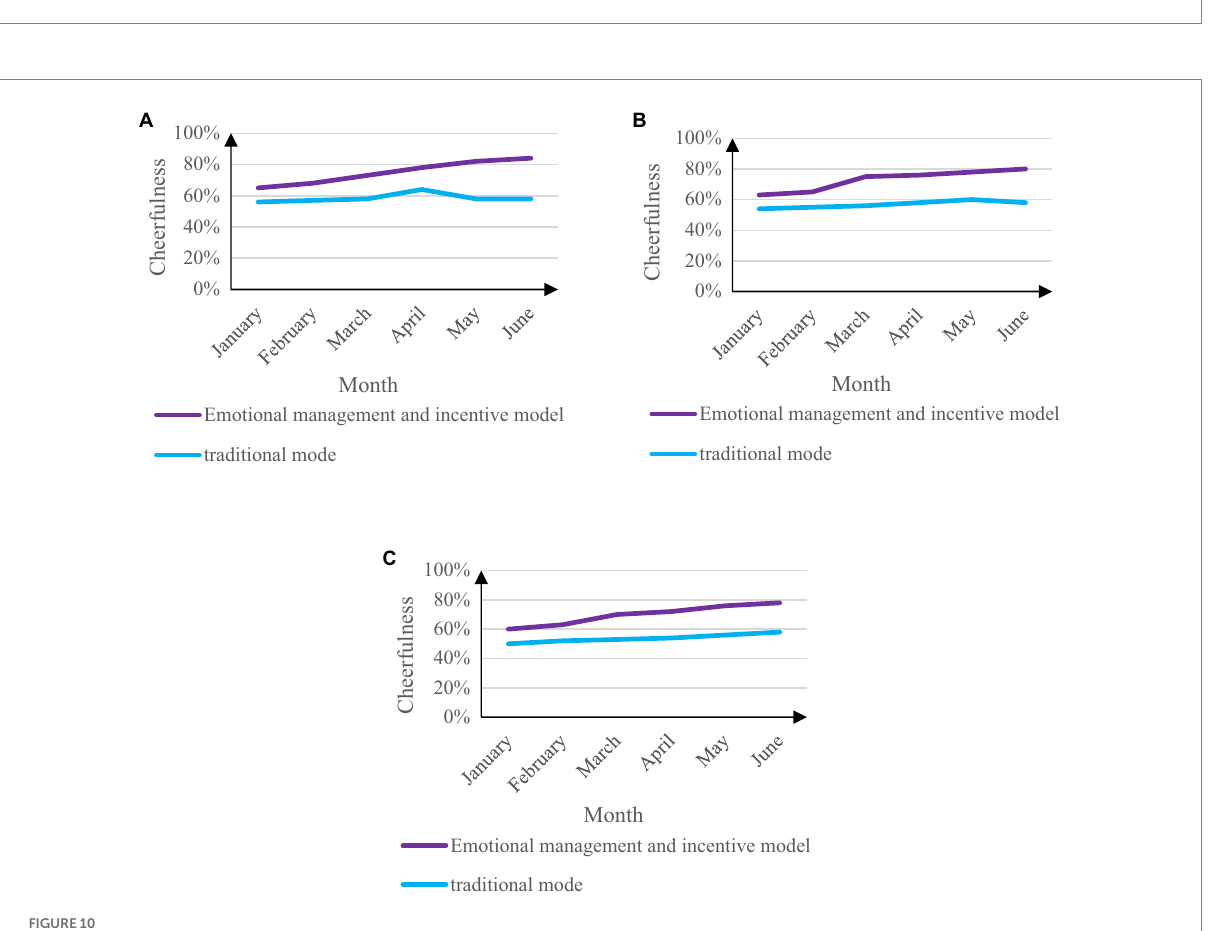
FIGURE 9 Comparison of student achievement improvement rates. (A) The rate of improvement for students in the previous semester. (B) The rate of improvement for students in the next semester.